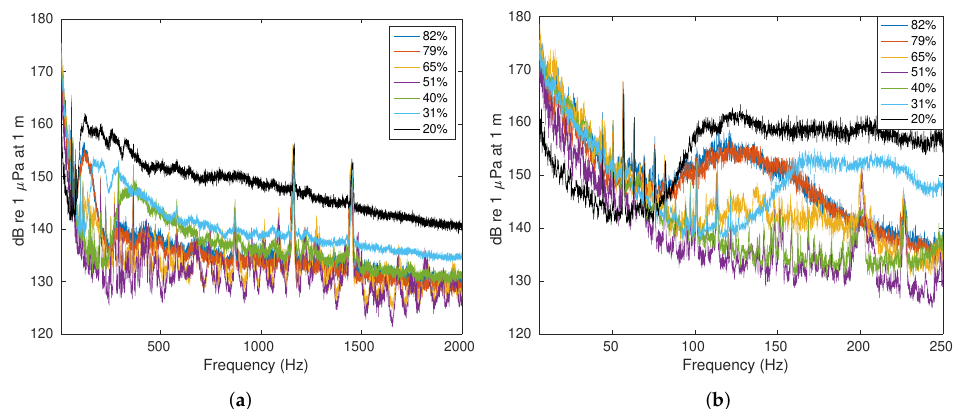
Figure 5. The power spectral density (PSD) distributions of ship-radiated underwater sound ( a ) up to 2000 Hz and ( b ) below 250 Hz at different propeller pitch ratios.